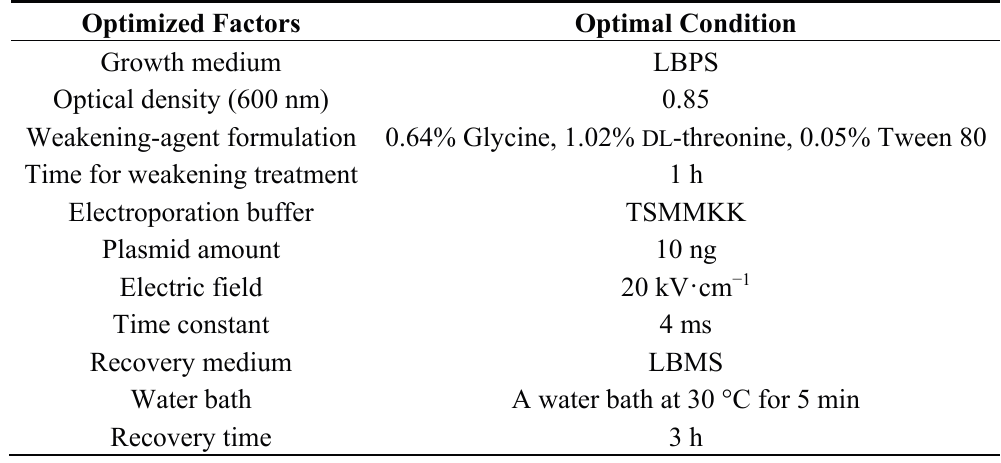
Table 6. Optimal electroporation condition for B. subtilis